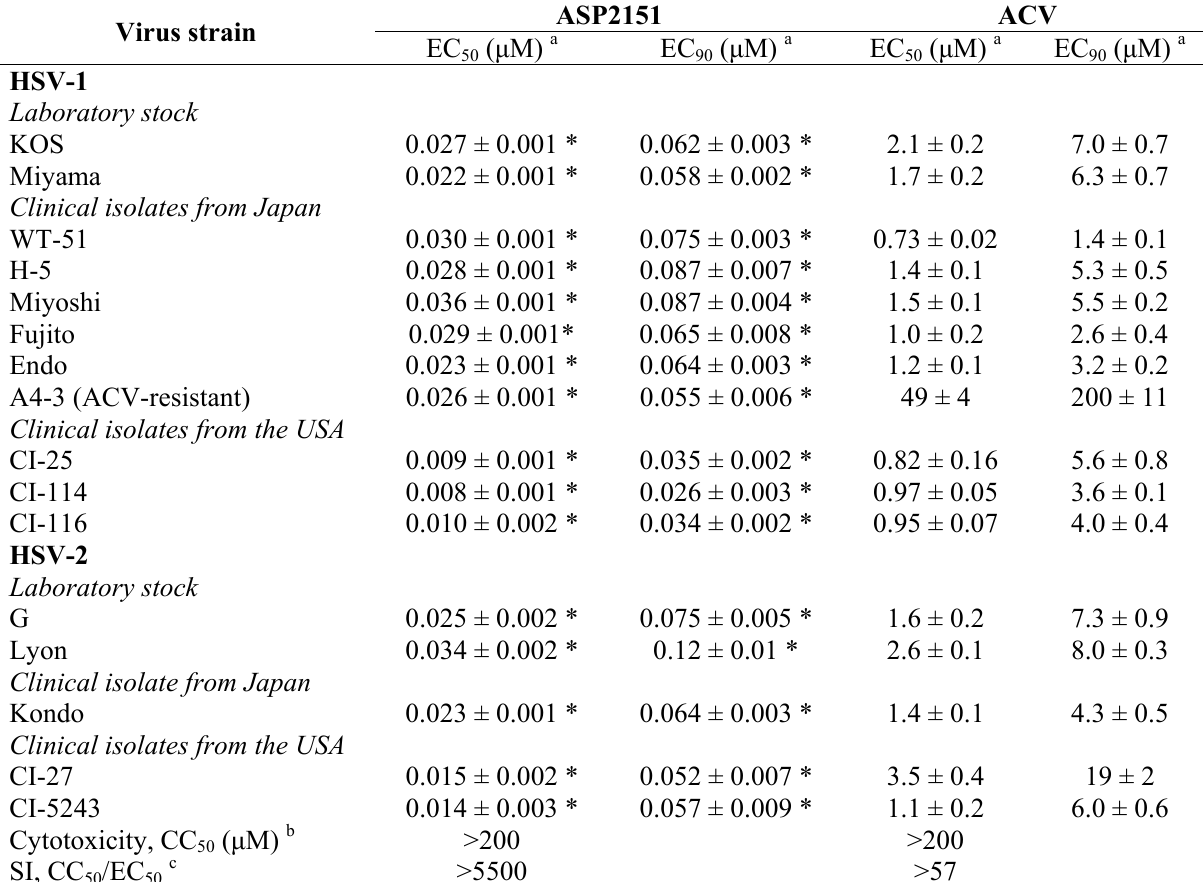
Table 1. Anti-HSV-1 and -2 activity and cytotoxicity of ASP2151 and ACV in Vero cells.